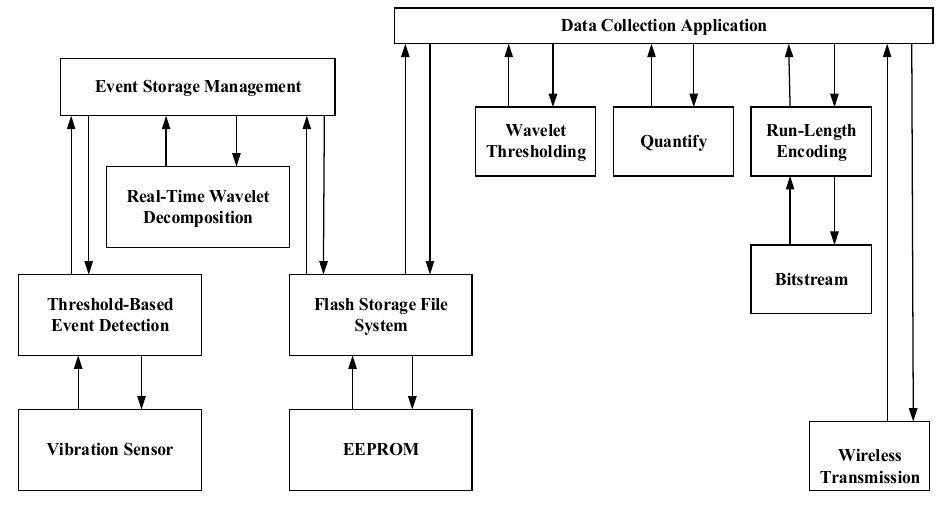
Figure 5. Data compression of